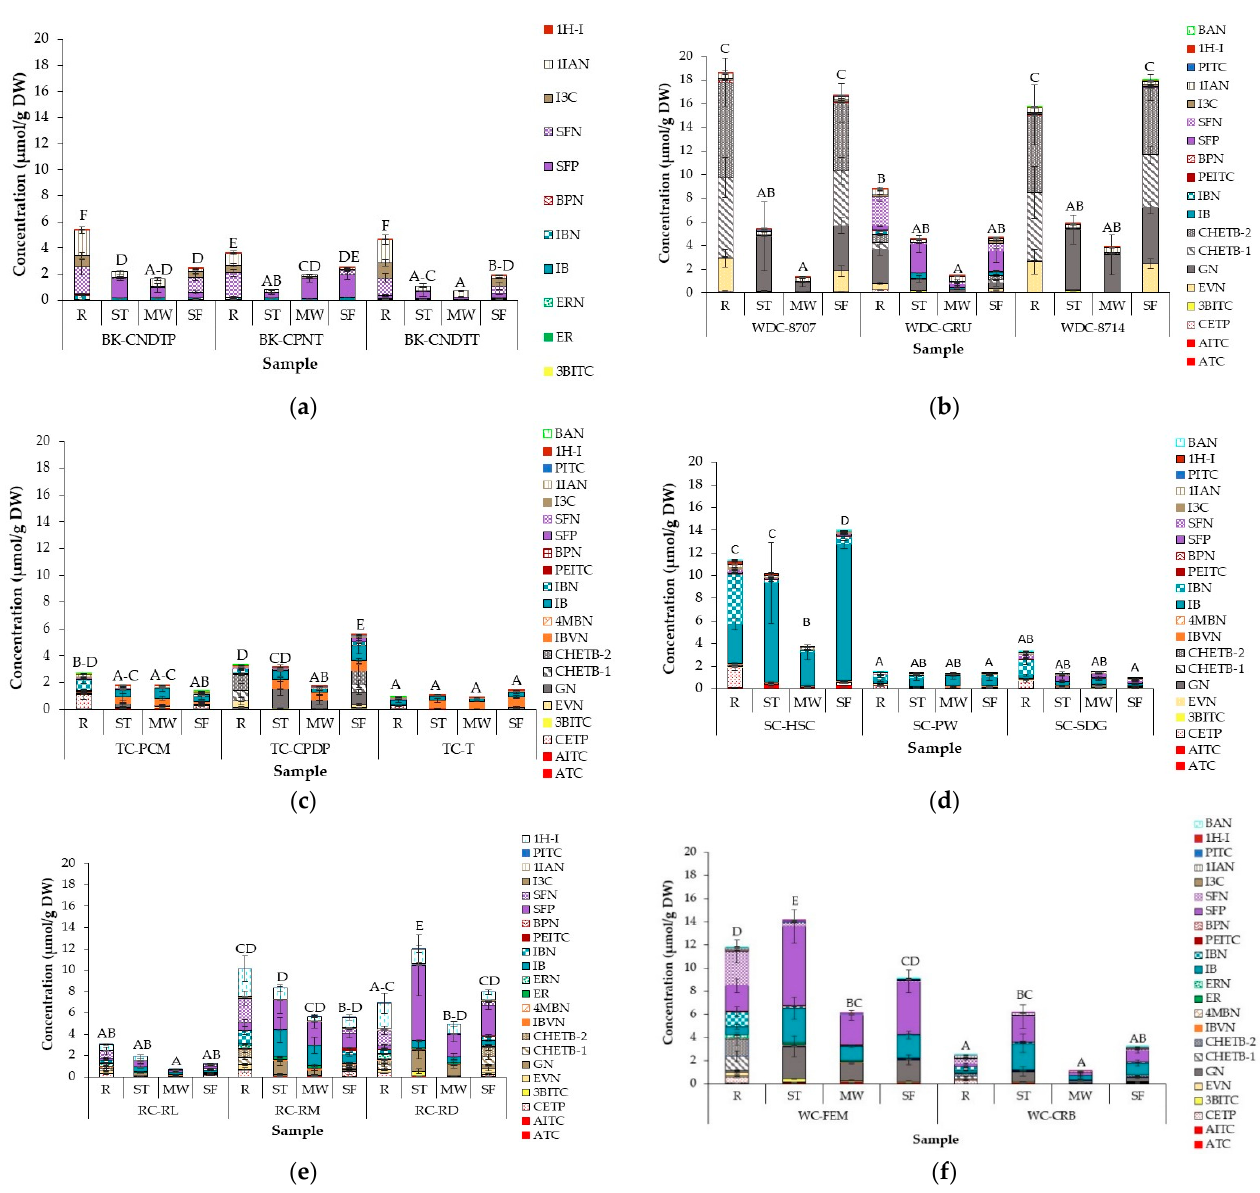
Figure 3. Glucosinolate hydrolysis products (GHPs) (µmol/g DW) in different accessions of ( a ) black kale; ( b ) wild cabbage ( c ) tronchuda cabbage; ( d ) Savoy cabbage; ( e ) Red cabbage and ( f ) white cabbage before and after domestic cooking. Results are expressed as sulforaphane equivalents. Error bars represent standard deviation from mean values. Letters above bars refer to differences in total GHP concentration. Letters ‘A–F’: bars not sharing a common uppercase letter differ significantly ( p < 0.05) between accessions and cooking methods within a cabbage morphotype (i.e., within each separate graph). For significant differences between cabbage morphotypes, accessions, and cooking methods (i.e., across the separate cabbage morphotype graphs), see Supplementary Table S5. Compounds with similar colour shades are GHPs (with nitriles in pattern fill) of corresponding GSL, presented in Figure 2. Abbreviations: R = raw, ST = steamed; MW = microwaved and SF = stir-fried; BK-CPNT: cavolo palmizio; BK-CNDTT: cavolo nero di toscana o senza testa; WD-8707: wild cabbage 8707; WD-GRU: wild cabbage 7338; WD-8714: wild cabbage 8714; TC-PCM: penca mistura; TC-CPDP: penca povoa; TC-T: tronchuda; SC-HSC: hybrid savoy wirosa; SC-PW: pointed winter; SC-SDG: dark green; RC-RL: red langendijker; RC-RM: rocco marner (Hybrid); RC-RD: red Danish; WC-FEM: early market; WC-CRB: couve repolho. For abbreviations of compounds, see Table 2